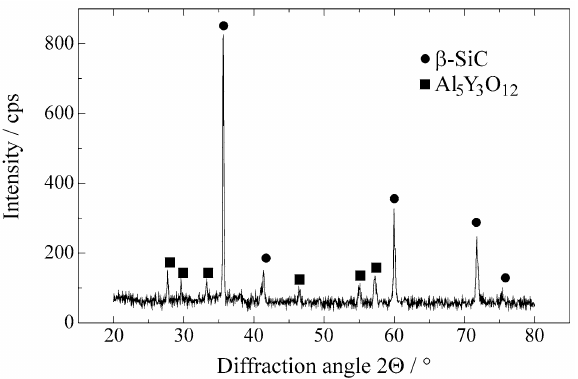
Figure 7. X-ray diffractogram of a SiC–Al 2 O 3 /Y 2 O 3 sample sintered at 2100